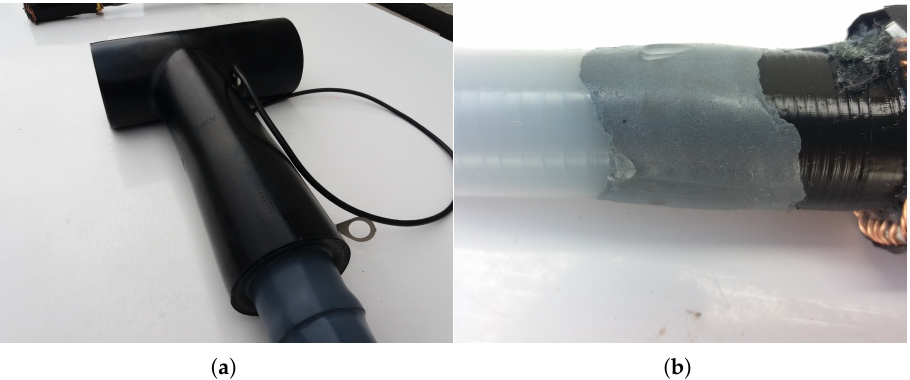
Figure 3. MV separable tee shape connector: ( a ) external view, ( b ) view of shield damage and control mantis